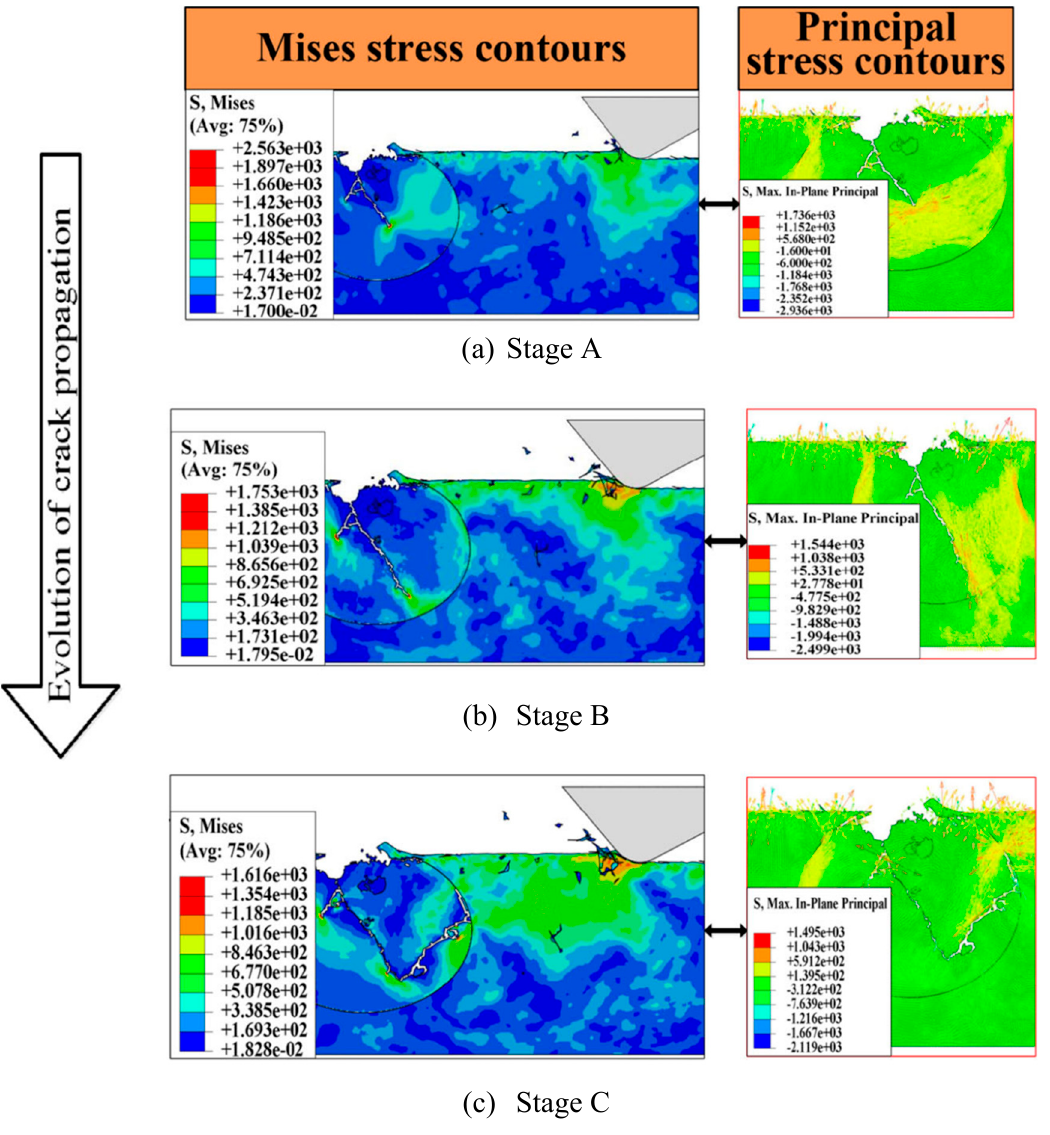
Figure 8. Evolution of the crack propagation for the second grinding grain. ( a ) initial stage, ( b ) developing and ( c ) complete [67].